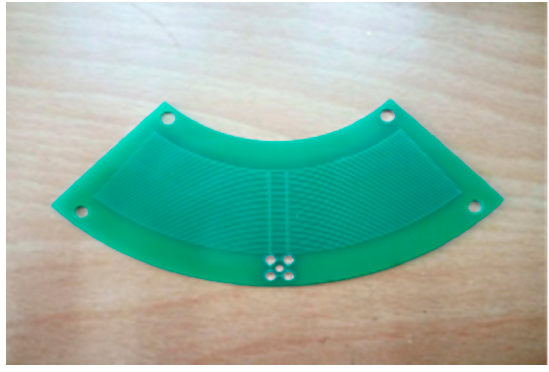
Figure 6. PCB of D-dot.